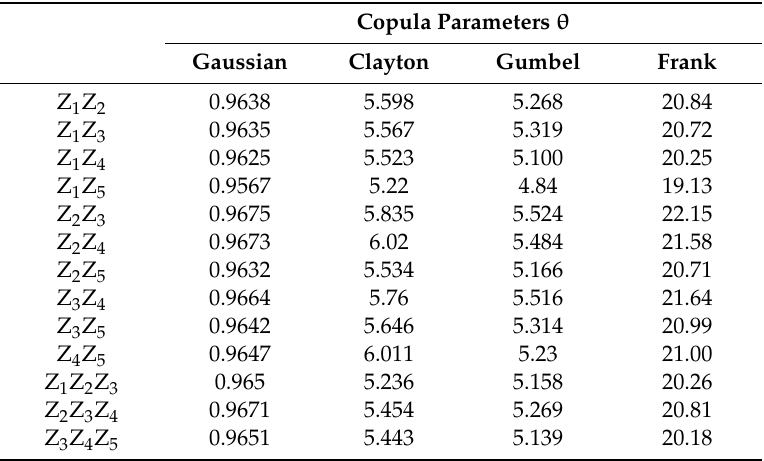
Table 3. Parameter values of candidate copula functions.